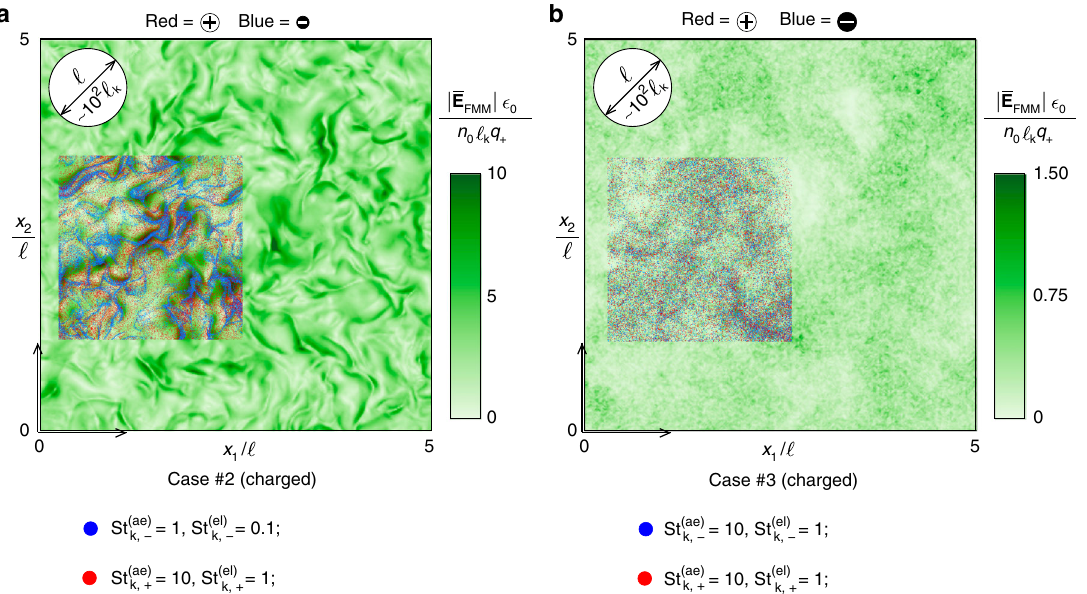
Fig. 4 Emergence of turbulence-driven electric fi elds. Instantaneous cross-sectional contours of the FMM-derived mesoscopic electric fi eld E FMM ð x Þ for a case #2, in which negatively charged small particles preferentially concentrate, and b case #3, in which none of the particle classes preferentially concentrate in any signi fi cant manner. The insets show the superposed local spatial distribution of negatively charged small particles (blue color dots) and positively charged large particles (red color dots) in a constant- x 3 slice of thickness equal to the Kolmogorov length ‘ k . The integral length ‘ and its equivalent size in Kolmogorov units (~100 ‘ k ) are provided for convenience in the left upper